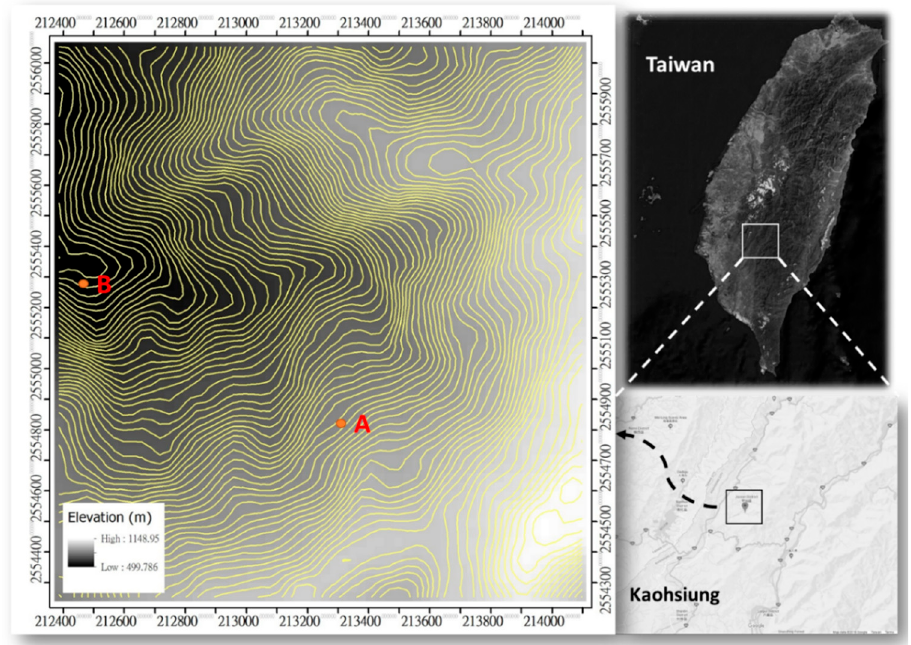
Figure 5. Catchment topography of the numerical experiment.